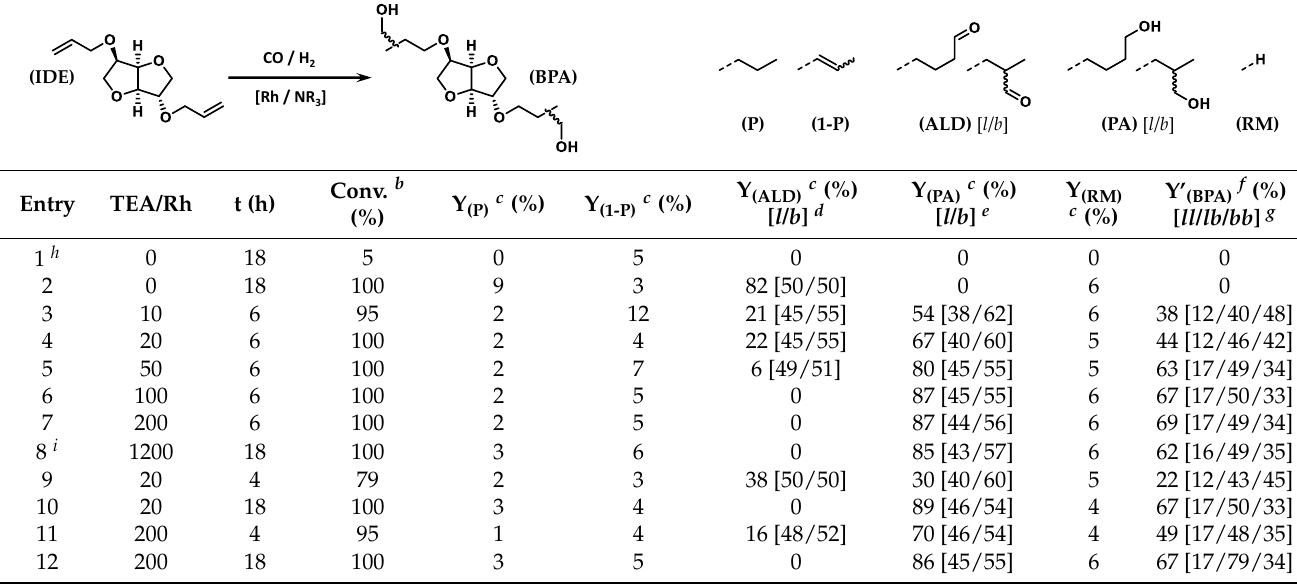
Table 1. Influence of the TEA amount on IDE hydrohydroxymethylation a .